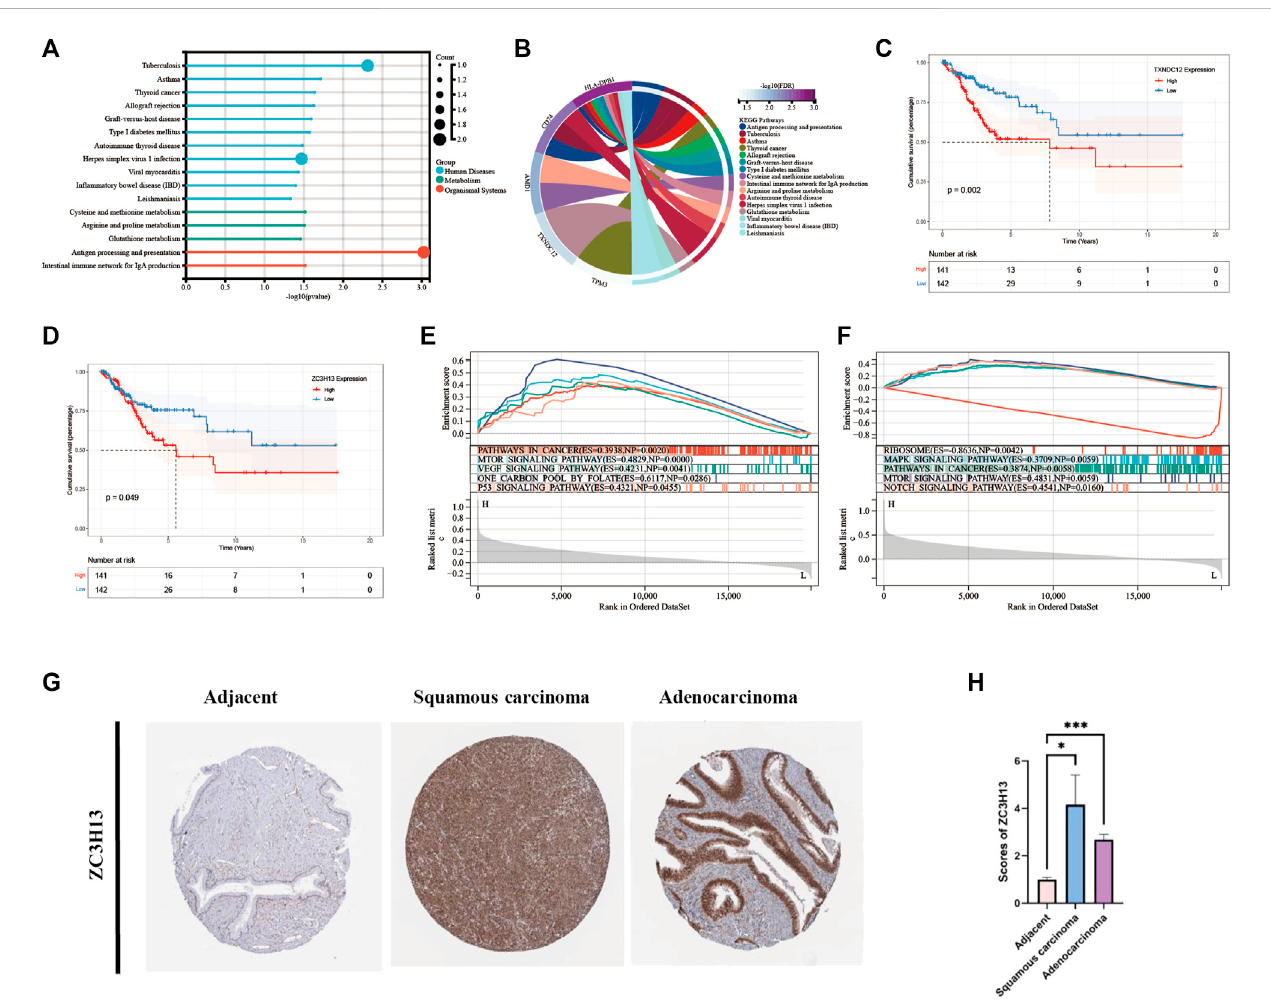
FIGURE 7 KEGG and GSEA analysis and Survival analysis of modeling genes and validation of ZC3H13 in CESC tissues. (A) . Histogram of KEGG pathway. (B) . Circle plot of KEGG pathway of modeling genes. (C) . Survival curve of TXNDC12 . (D) . Survival curve of ZC3H13 . (E) . GSEA pathway analysis of TXNDC12 . (F) GSEA pathway analysis of ZC3H13 . (G,H). Quanti fi cation and comparison of protein expression of ZC3H13 by IHC. (* < 0.05, ** < 0.01, *** <